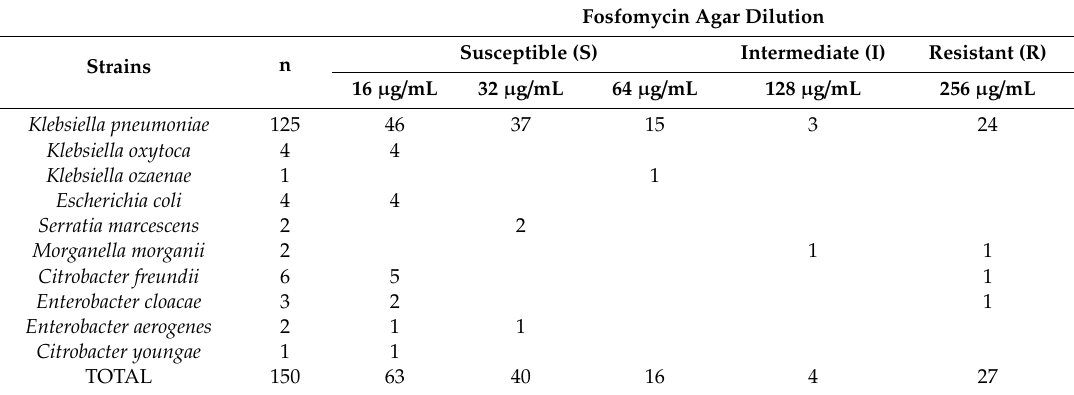
Table 1. Fosfomycin Minimum Inhibitory Concentration (MIC) distribution in all isolates.